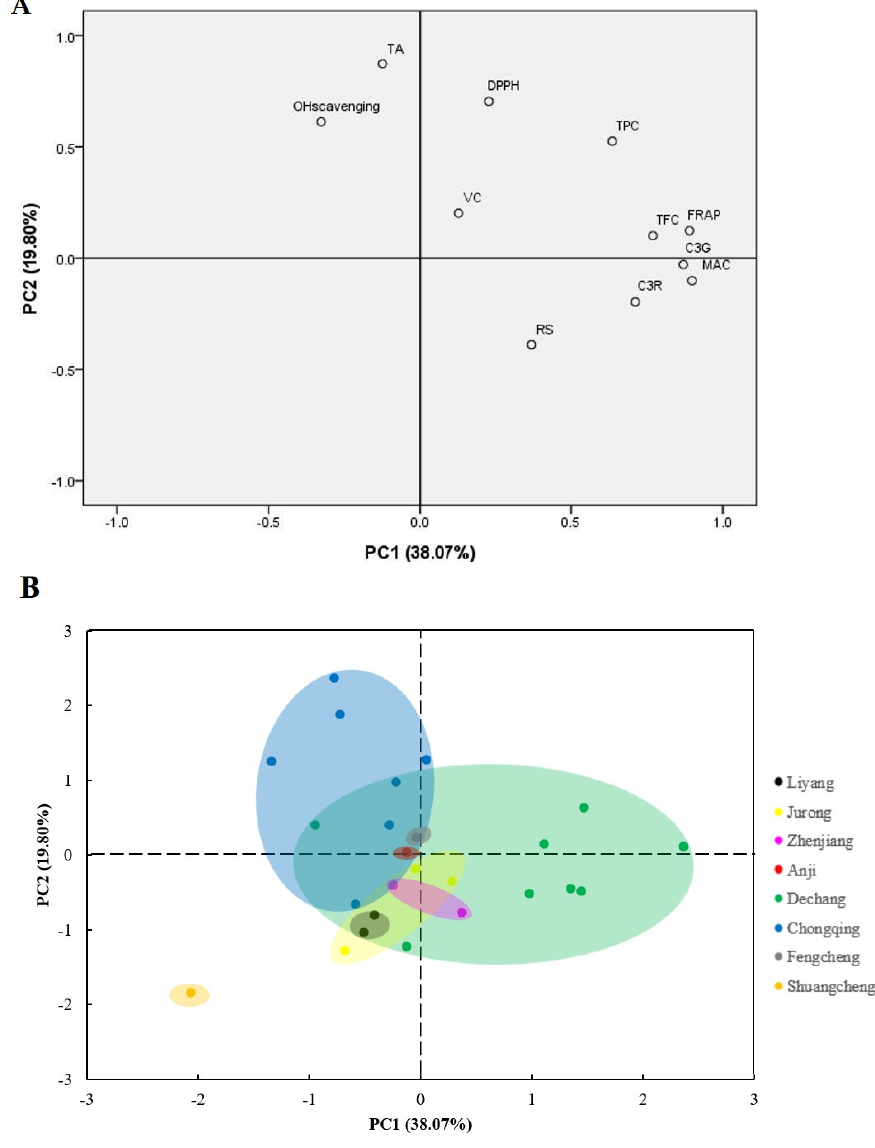
Figure 4. Principal component analysis loading plot of TPC, TFC, antioxidant activity, and active compounds from different locations in China ( A ), and the principal component analysis score plot of different mulberry samples in China ( B ).